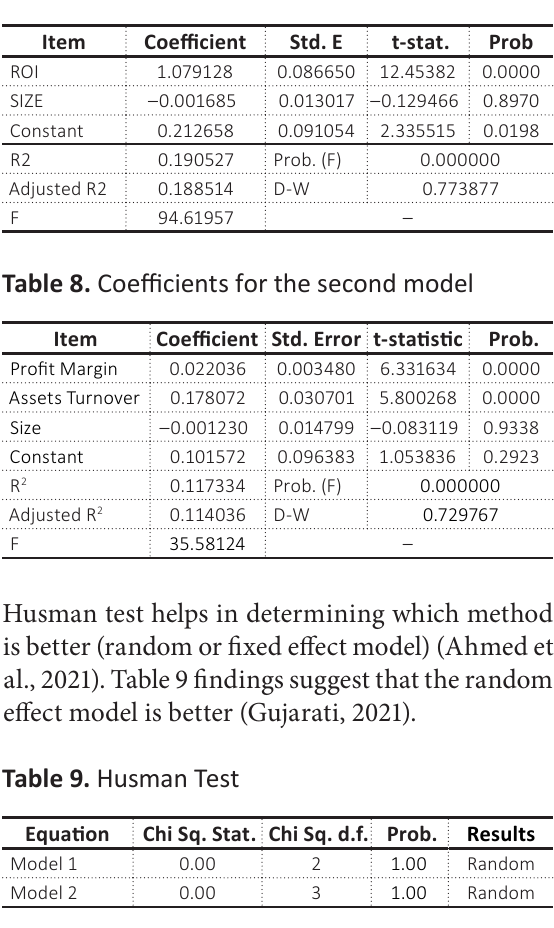
Table 5. Results for the first model